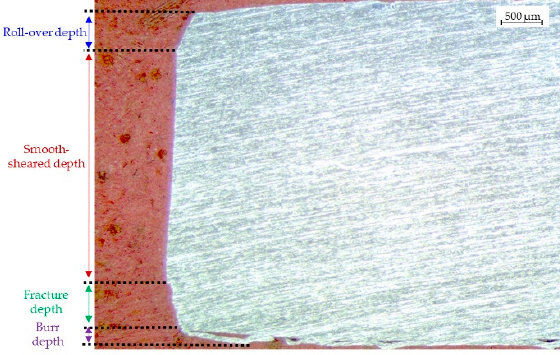
Figure 5. Different zones of the edges after shearing.